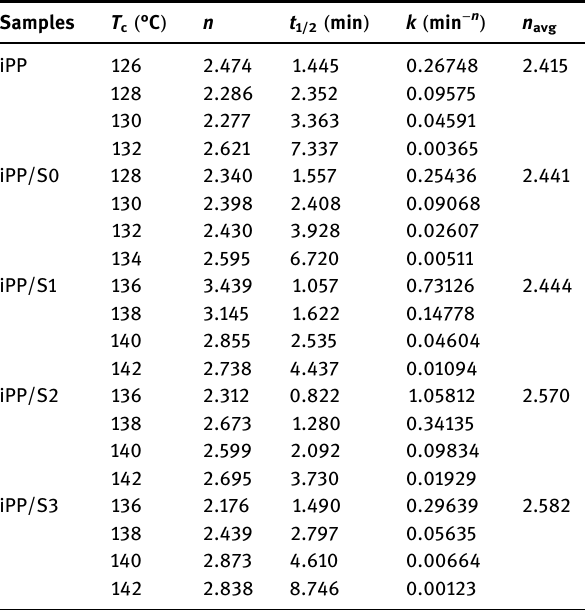
Table 3: Isothermal crystallization data of iPP composite